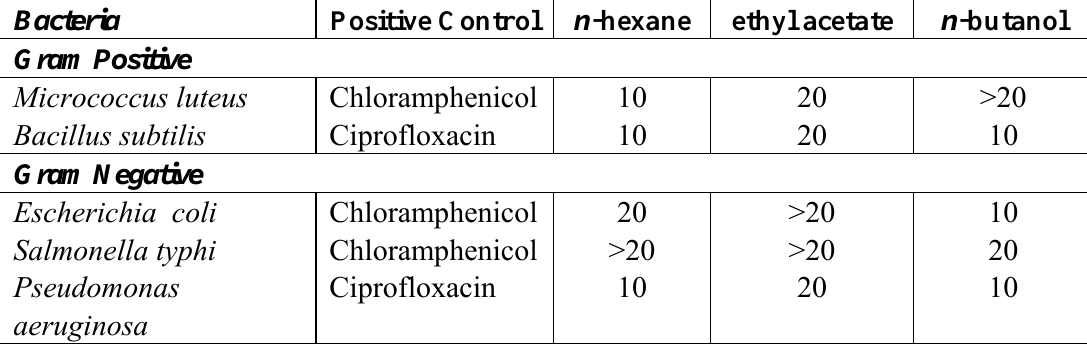
Table 3 . Minimum Bactericidal Concentrations (mg/mL) of Different Fractions of Dodonaea